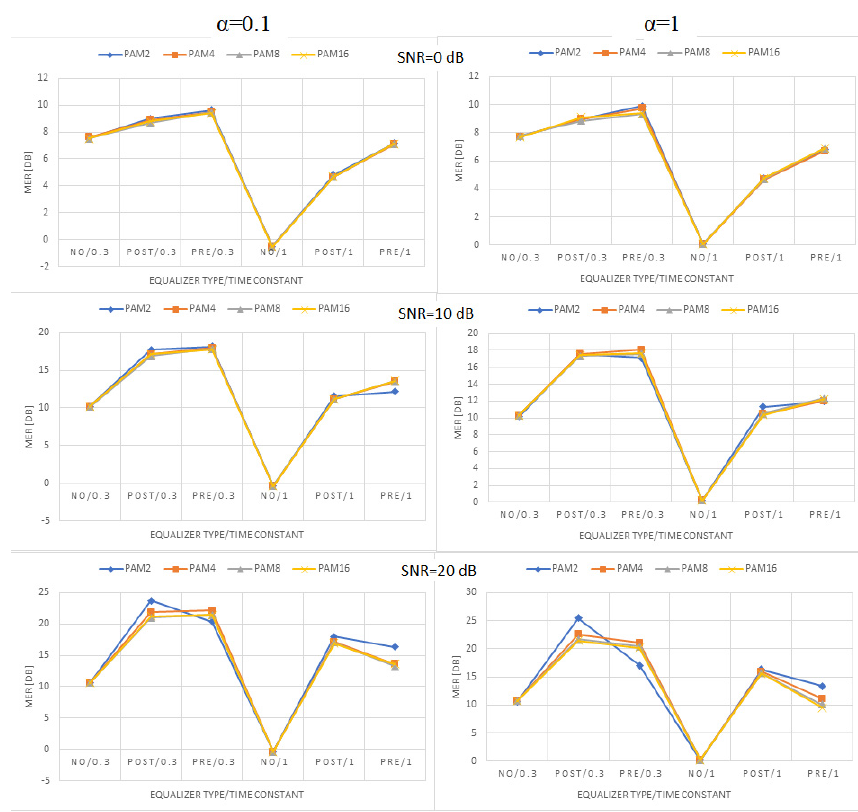
Figure 10. MER values obtained for the moderate nonlinearity ([1, − 0.1, 0.05, 0.02]).